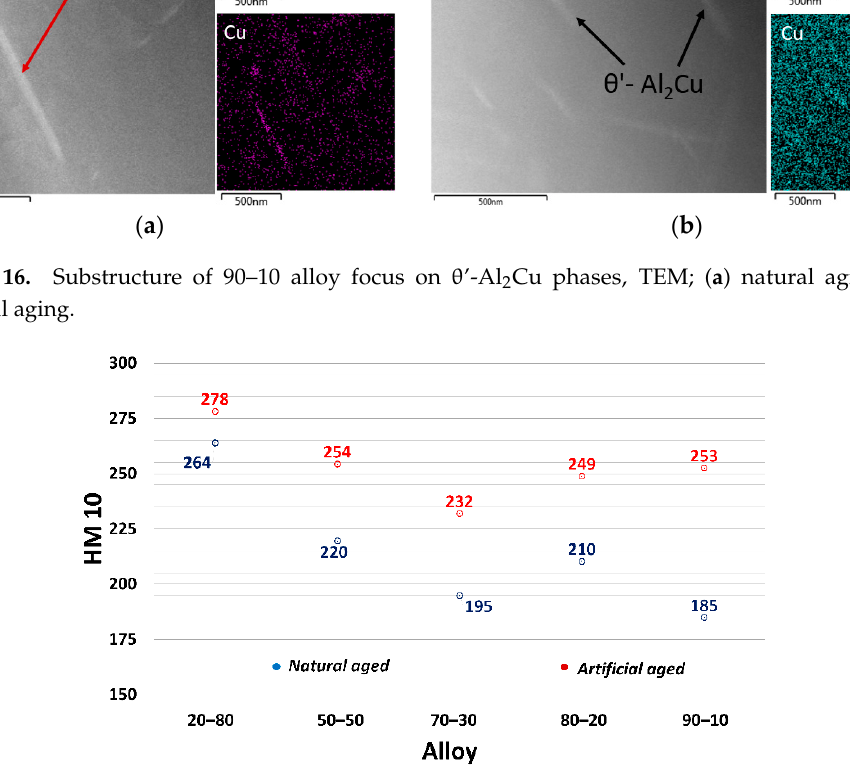
Figure 17. Dependence of the microhardness of the primary α -phase on AlSi9Cu3 alloys from the different ratio of remelted returnable material in the batch.